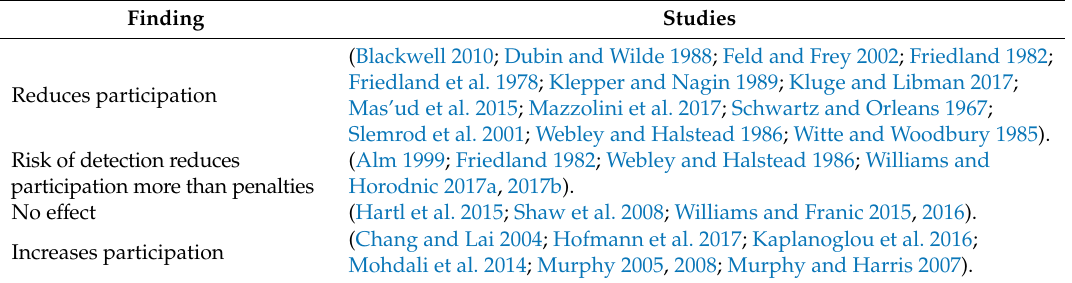
Table 1. Relationship between increasing penalties and risk of detection and tax